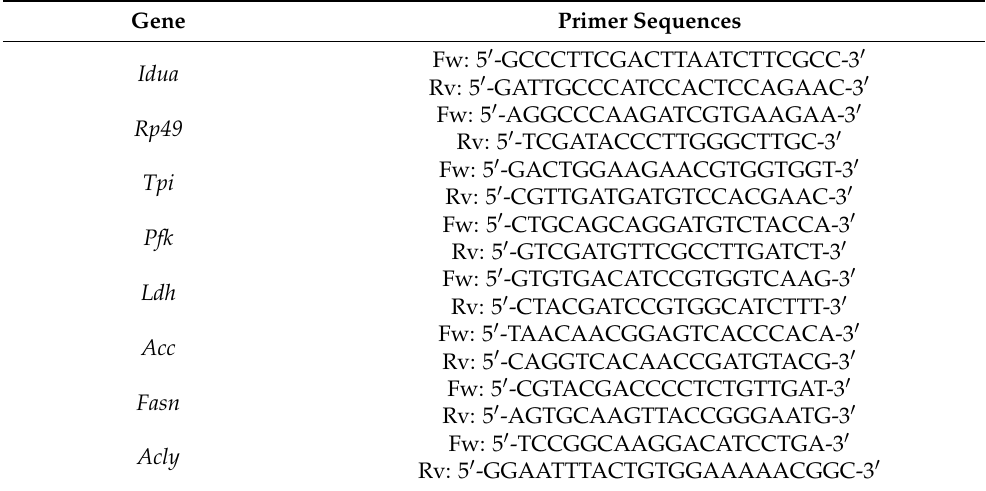
Table 2. Drosophila primer pairs used for the qRT- PCR